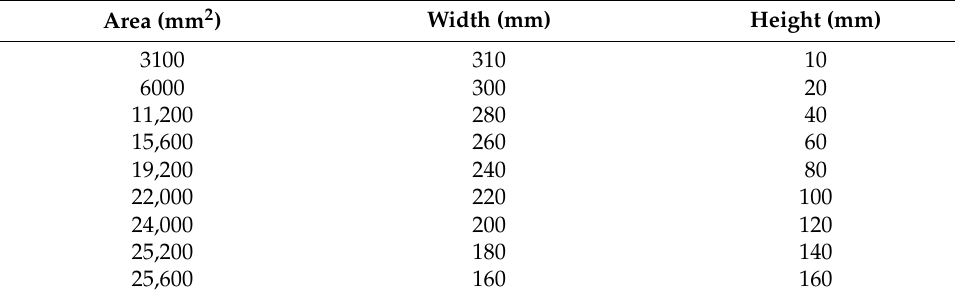
Table 7. Single loop rectangle dimensions with a constant perimeter (640 mm).